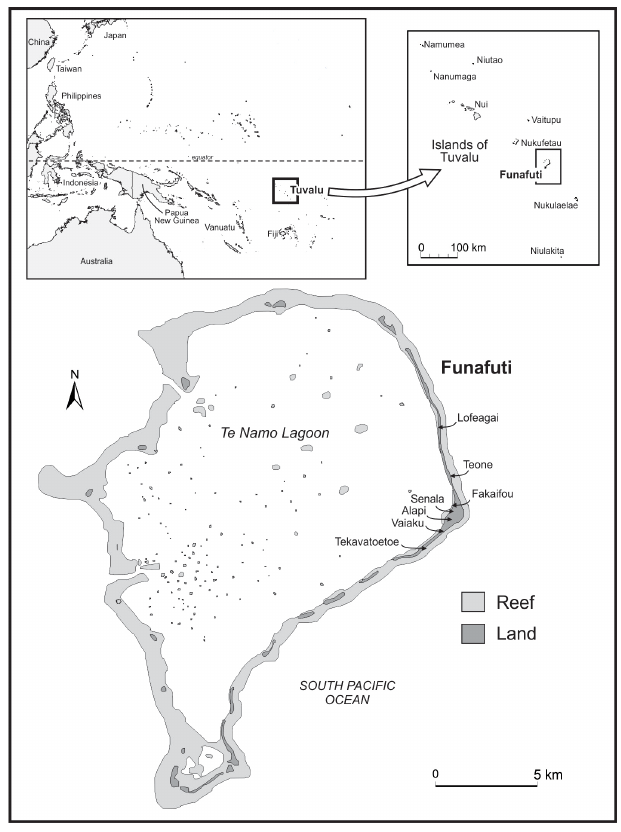
Fig. 1. Funafuti and the location of Tuvalu among Pacific